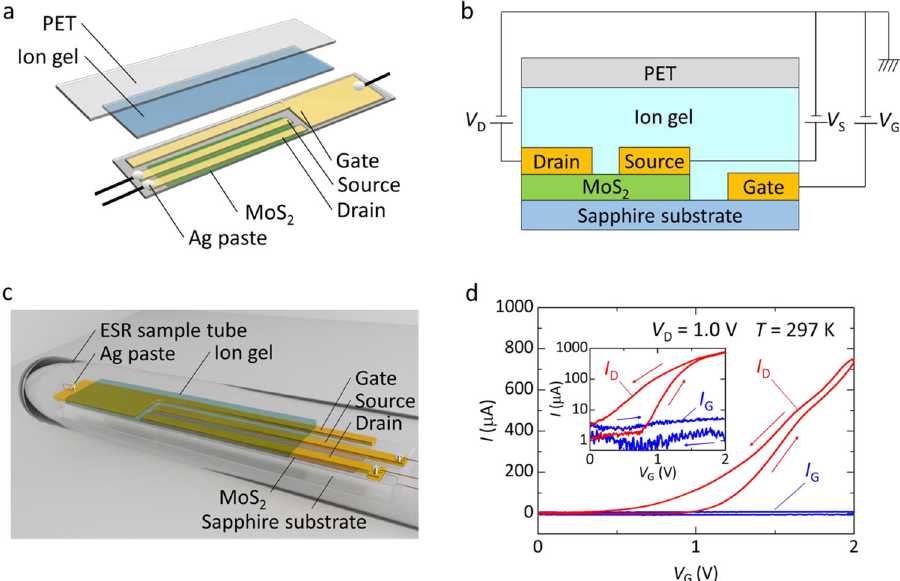
Fig. 1 MoS 2 transistor structure and device characteristics. a Schematic diagram of the device structure of a MoS 2 transistor used for ESR measurements. b Schematic cross-section of the device structure. c Schematic diagram of the MoS 2 transistor in an ESR sample tube. d Transfer characteristic of the MoS 2 transistor. The inset shows a plot of the transfer characteristics in logarithmic